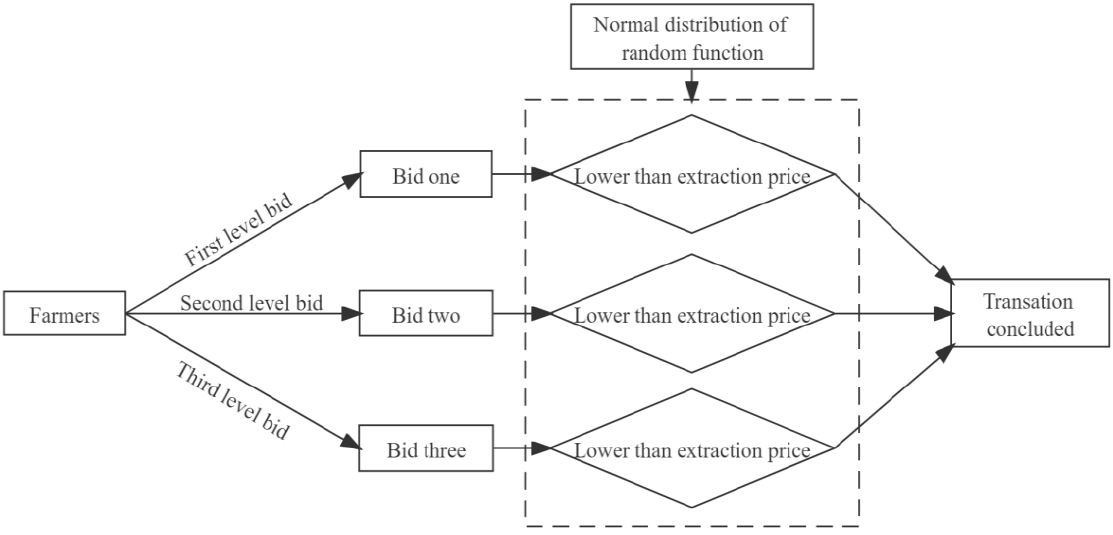
Figure 3. BDM mechanism program.